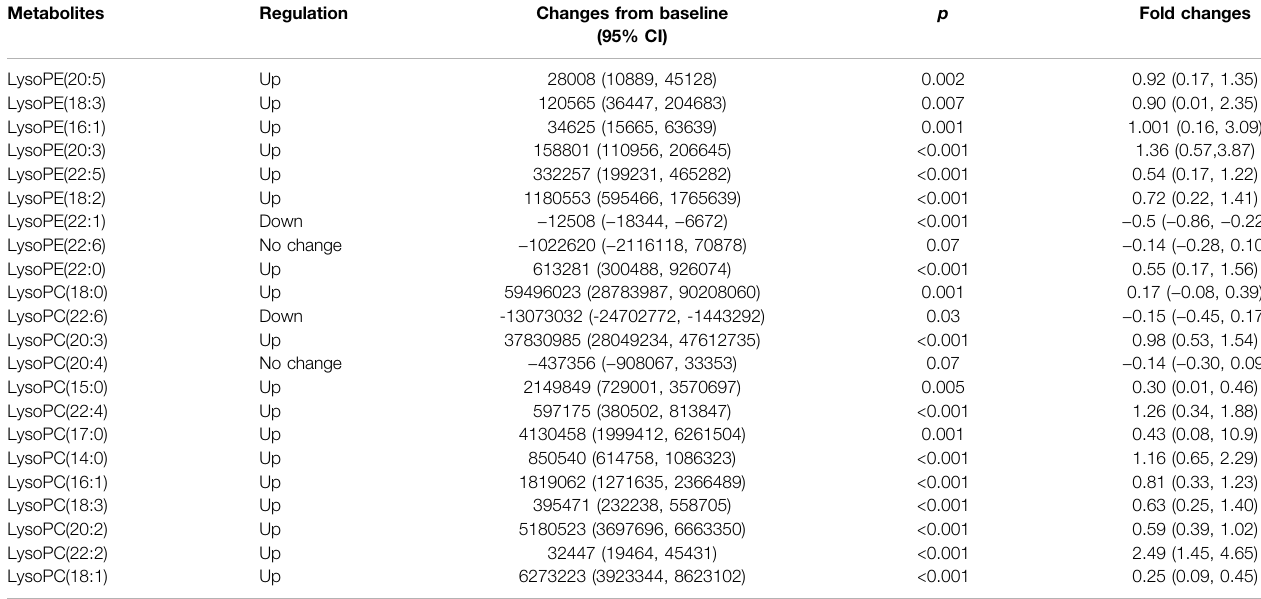
PC, phosphatidylcholine; PE, phosphatidylethanolamine; CI, con fi dence. Change refers to the levels of metabolites at follow-up minus the levels at